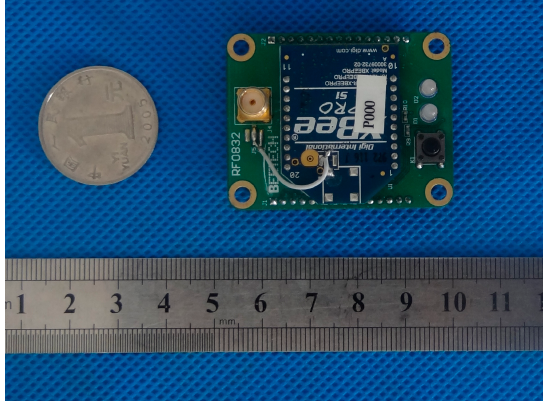
Figure 9. Wireless radio frequency module.